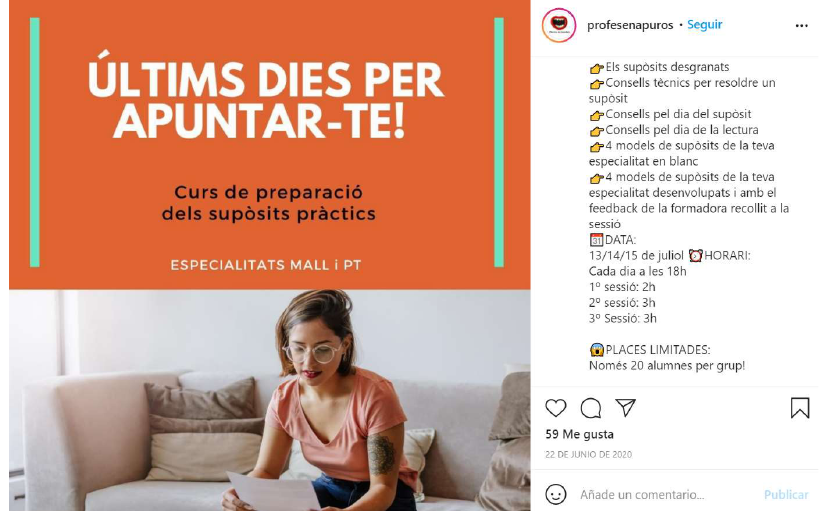
Figure 9. Example of publication for economic purposes. In the image @2profesenapuros shares different training programs and materials that are offered to its clients, limited by study